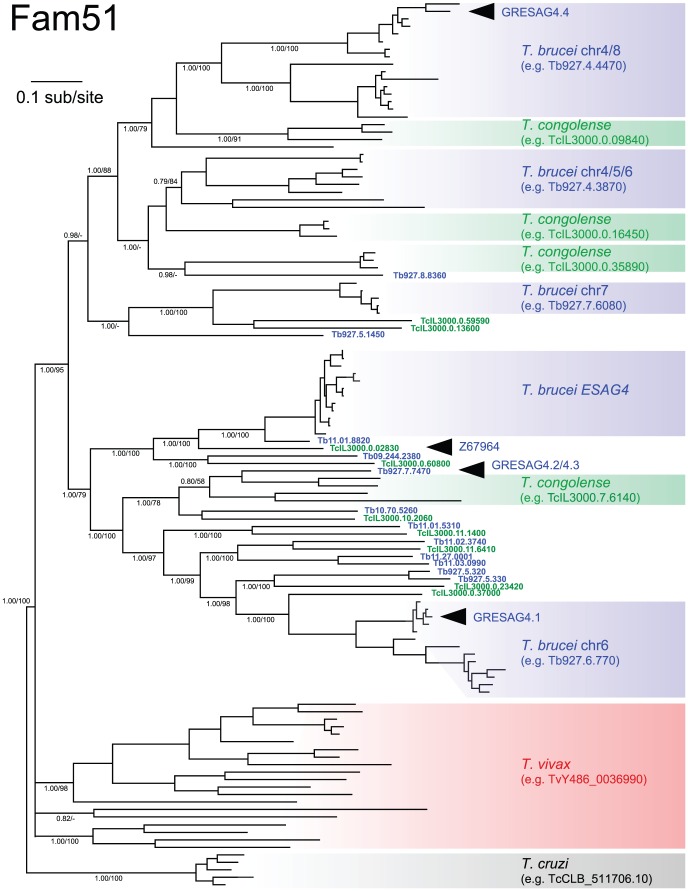
Bayesian phylogeny of adenylate cyclase genes from African trypanosomes (Fam51).The phylogeny was estimated from an amino acid sequence alignment of 1239 characters including all adenylate cyclase proteins from T. brucei 927, T. congolense IL3000 and T. vivax Y486, as well as ESAG4 sensu stricto from T. brucei 927, 427 and T. b. gambiense 972. A mixed amino acid substitution strategy was applied with default settings using MrBayes v3.2.1. The phylogeny is rooted using an outgroup of selected T. cruzi homologs that represent total diversity. Bayesian posterior probability/non-parametric bootstrap values are provided for selected nodes. Black arrows denote the positions of previously named ‘GRESAG4’ sequences, as well as an ESAG4-like cDNA from T. congolense (Z67964; [85]).